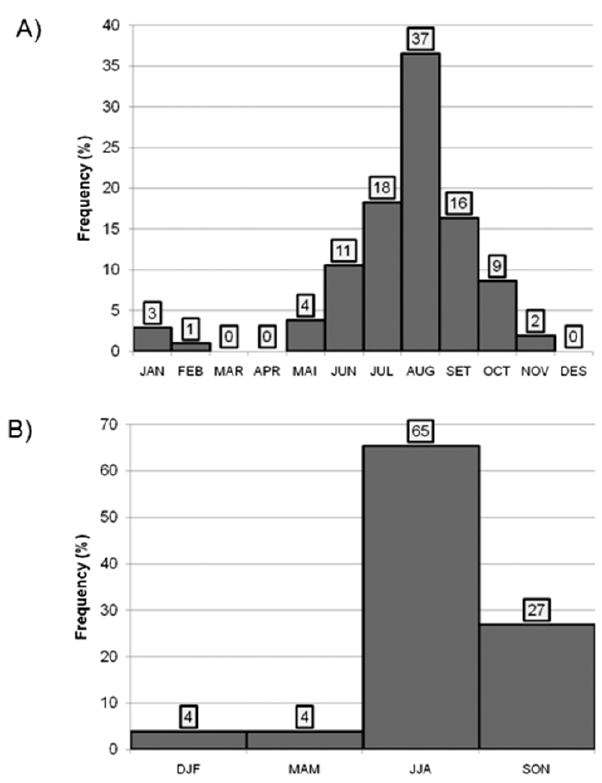
Figure 2. (a) Monthly distribution of major floods in Switzerland for the period 1800–2009 for very severe (VS) and catastrophic (c) flood categories. (b) Seasonal distribution of VS and C